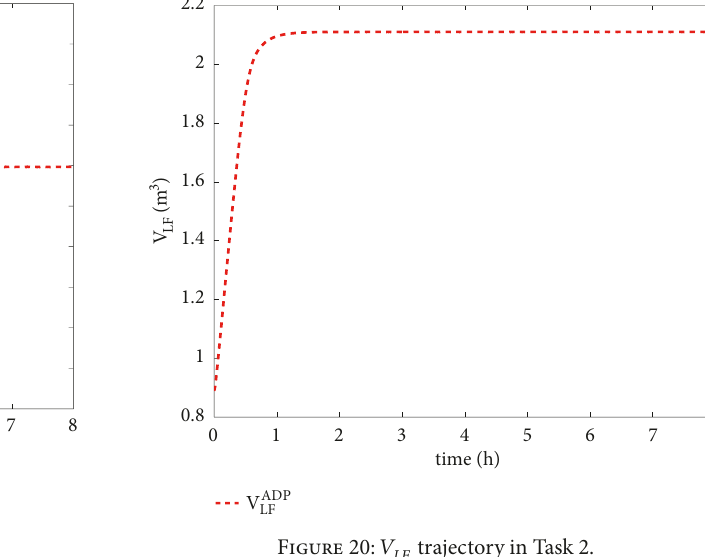
Figure 20: 𝑉 𝐿𝐹 trajectory in Task 2.